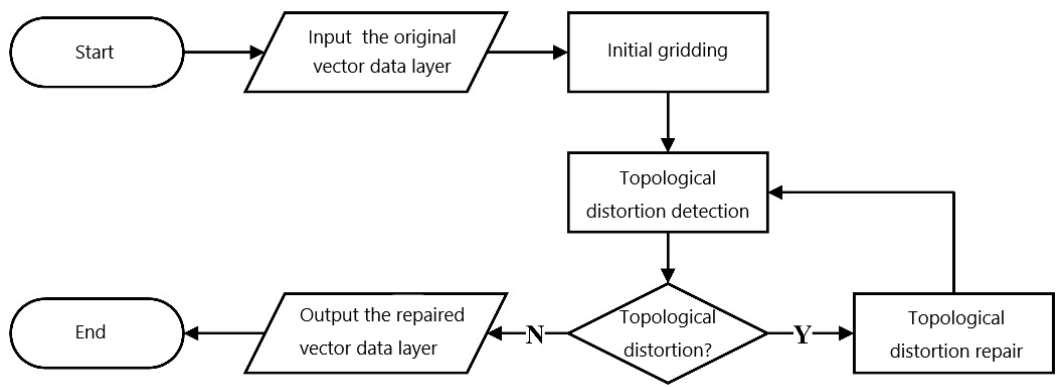
Figure 2. The overall process of this method.